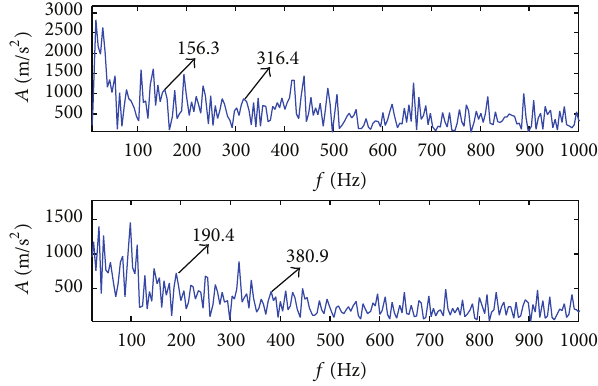
Figure 9: Spectrum with BSS based on NSP processing. 6307 bearings: (3) is a normal bearing and (5) is the bearing with different pitting modes. The rotating speed of motor is 𝑅 = 1496 r/min, the outer diameter of the bearing is 𝐷 = 80 mm, and the inner diameter is 𝑑 = 35 mm. The number of rolling elements is 𝑍 = 8 , and the contact angle is 𝛼 = 0